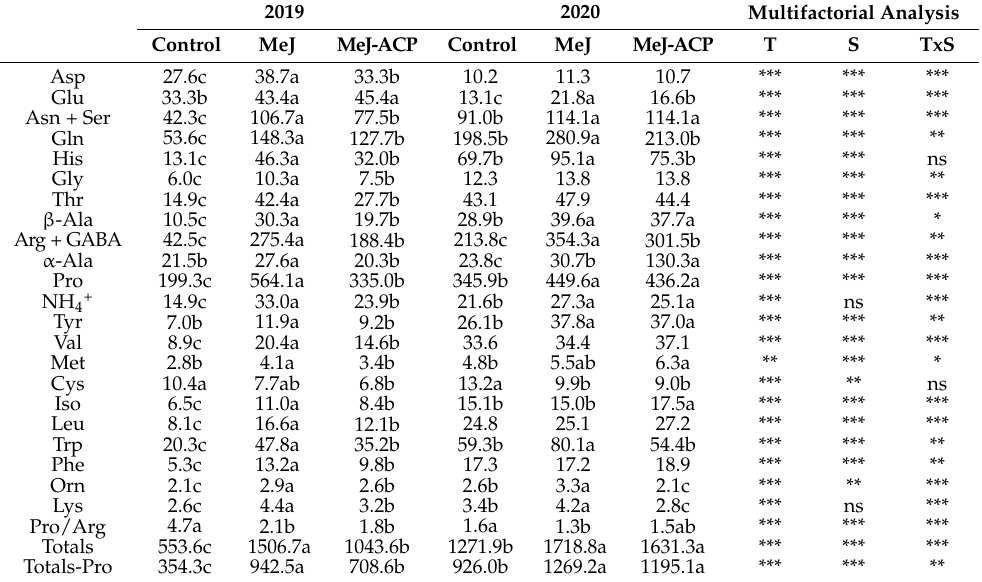
Table 3. Nitrogen composition in Monastrell musts from non-treated and treated grapes with MeJ and MeJ-ACP (expressed as mg